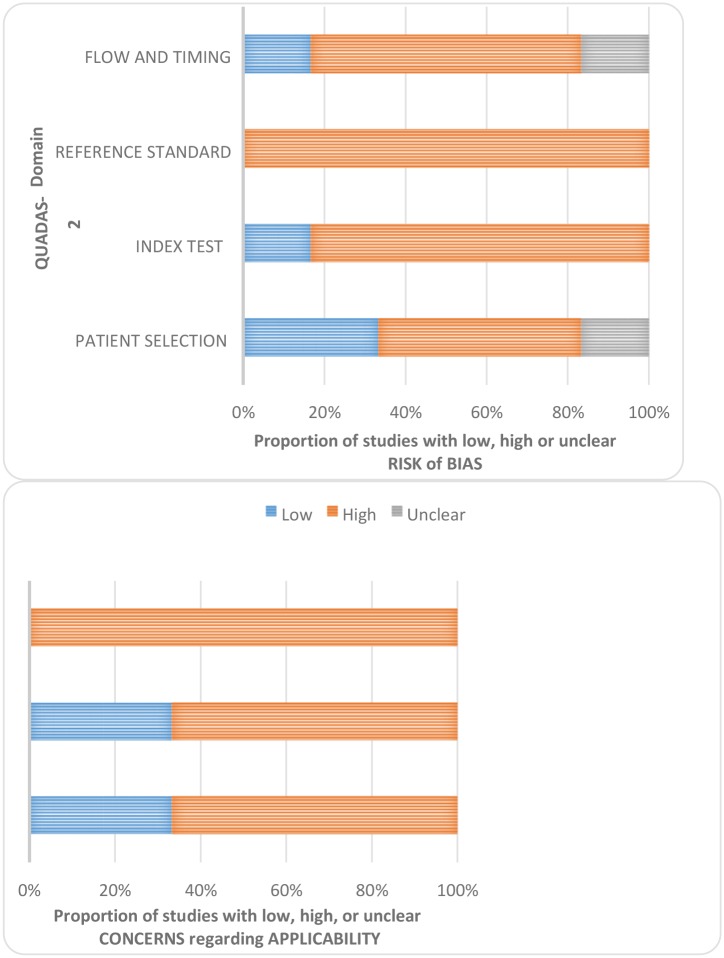
QUADAS-2 results.